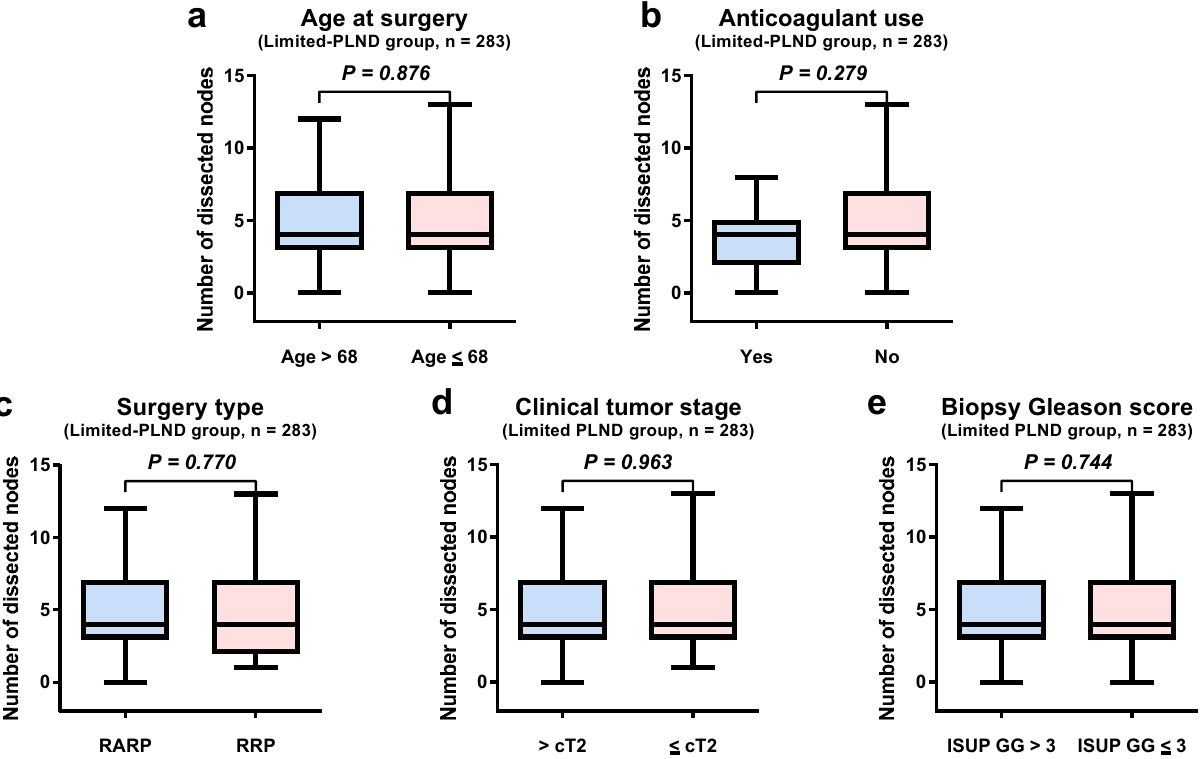
Figure 2. Number of dissected nodes stratified by age at surgery ( a ), anticoagulant use ( b ), surgery type ( c ), clinical tumor stage ( d ), and biopsy Gleason score ( e ) in the limited-PLND group. PLND pelvic lymph node dissection, RARP robot-assisted radical prostatectomy, RRP retropubic radical prostatectomy, ISUP GG the International Society of Urological Pathology grade group.